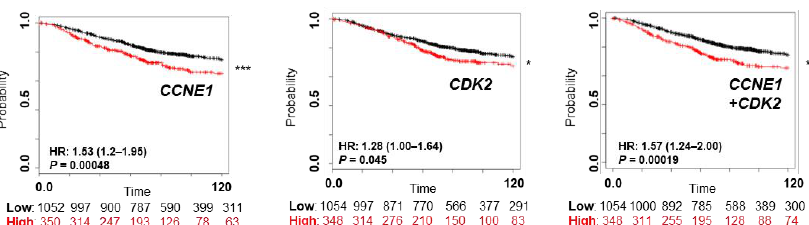
Figure 1. Basal-like/TNBC is associated with an upregulated expression level of the cyclin E/CDK2 partner. ( A ) Gene expression analysis of primary tumors from Guy’s (TNBC-enriched, n = 177), TCGA ( n = 578) and METABRIC ( n = 1197) cohorts of CDK and cyclin genes involved in cell cycle. Color scale indicates log2 expression values (yellow, higher; black, lower expression). Cohorts were divided into TNBC, ER+ and HER2+ groups based on their IHC-defined receptor status, in addition to PAM50 classification (Basal-like, HER2-enriched, luminal A, luminal B and normal-like). ( B ) CCNE1 and CDK2 expression levels were stratified according to their IHC-defined receptor status, or ( C ) PAM50 classification (Basal-like (BL), HER2, luminal A (LumA), luminal B (LumB) and normal-like (NL)). Median-centered gene expression log2 values are shown. Numbers of patients per group are indicated below the graphs. p- values were determined using a Mann – Whitney U test. ( D ) Kaplan – Meier curves shows the association of CCNE1 and CDK2 expression (upper quartile (red line) compared to the other curves (black line)) with ten-year overall survival in 1402 breast cancer samples. Significant p -values are indicated with an asterisk, whereas * p < 0.05; ** p < 0.005; *** p < 0.0005.